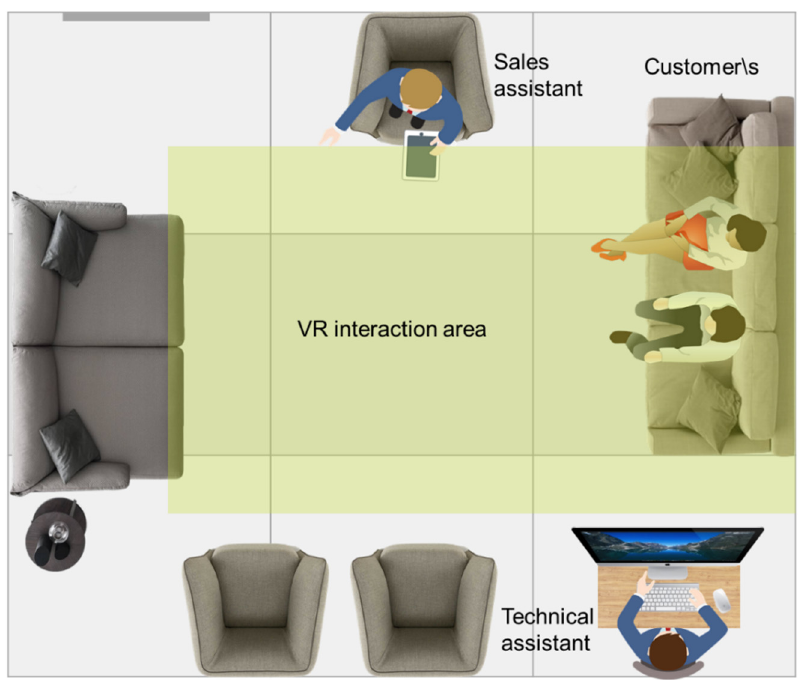
Figure 2. An example of layout (3 × 3 m) for the dedicated store area to the MSISVRCJ. The Touchpoints